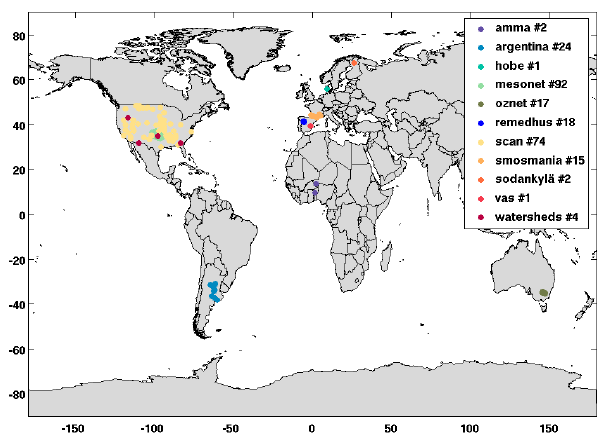
Figure 21. The 11 in-situ soil moisture networks and the position of their sites. The legend reports the network name, its associated colour and the number of the sites we considered for a total of 250 sites.